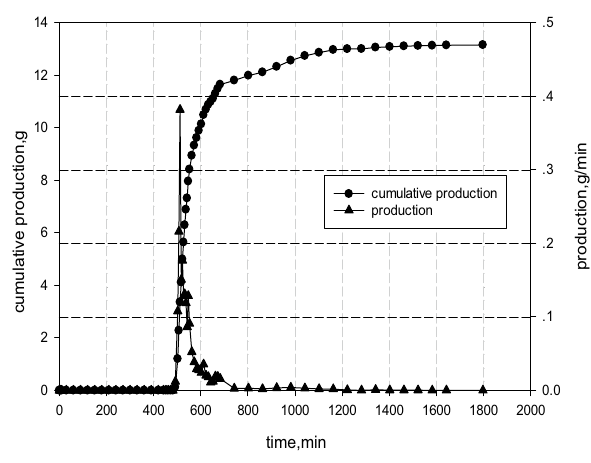
Fig. 3 Production rate and cumulative oil production curves in the CO 2 pressure-recovery flooding